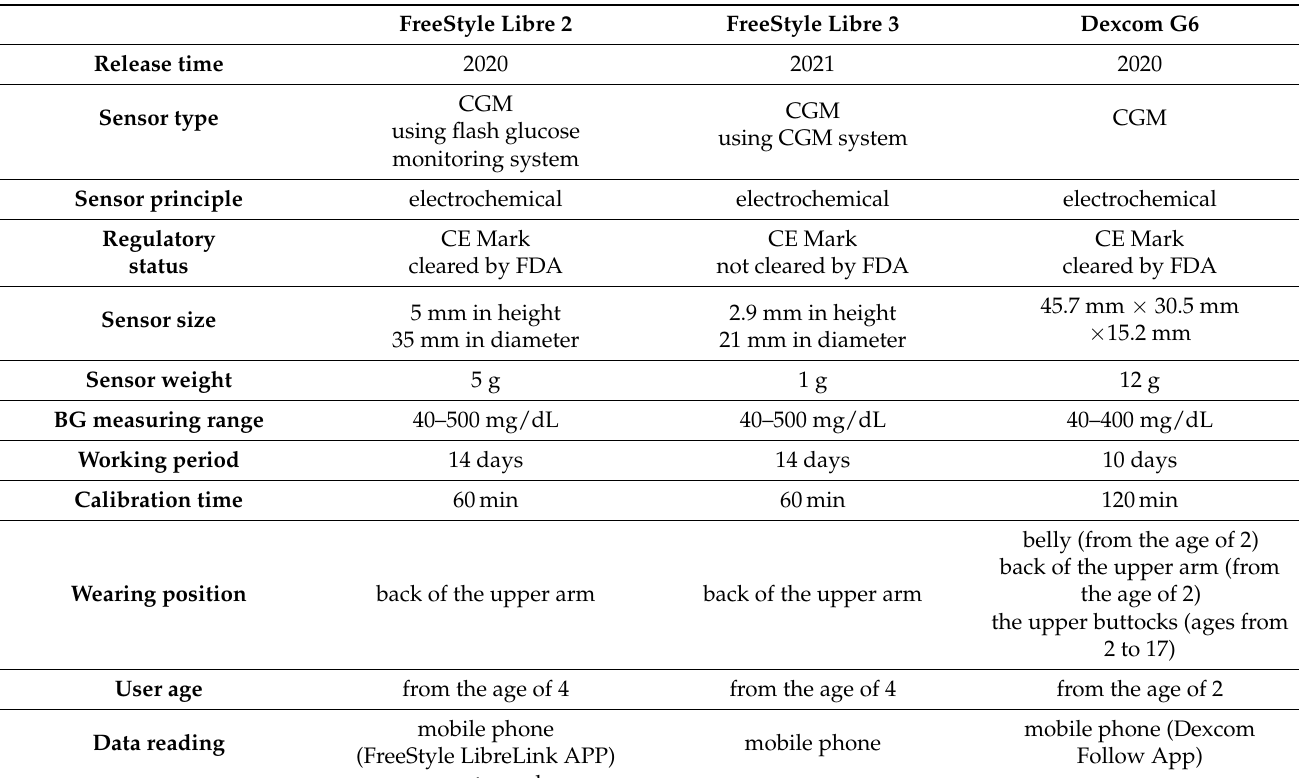
Table 9. Technical data comparison between FreeStyle Libre and Dexcom